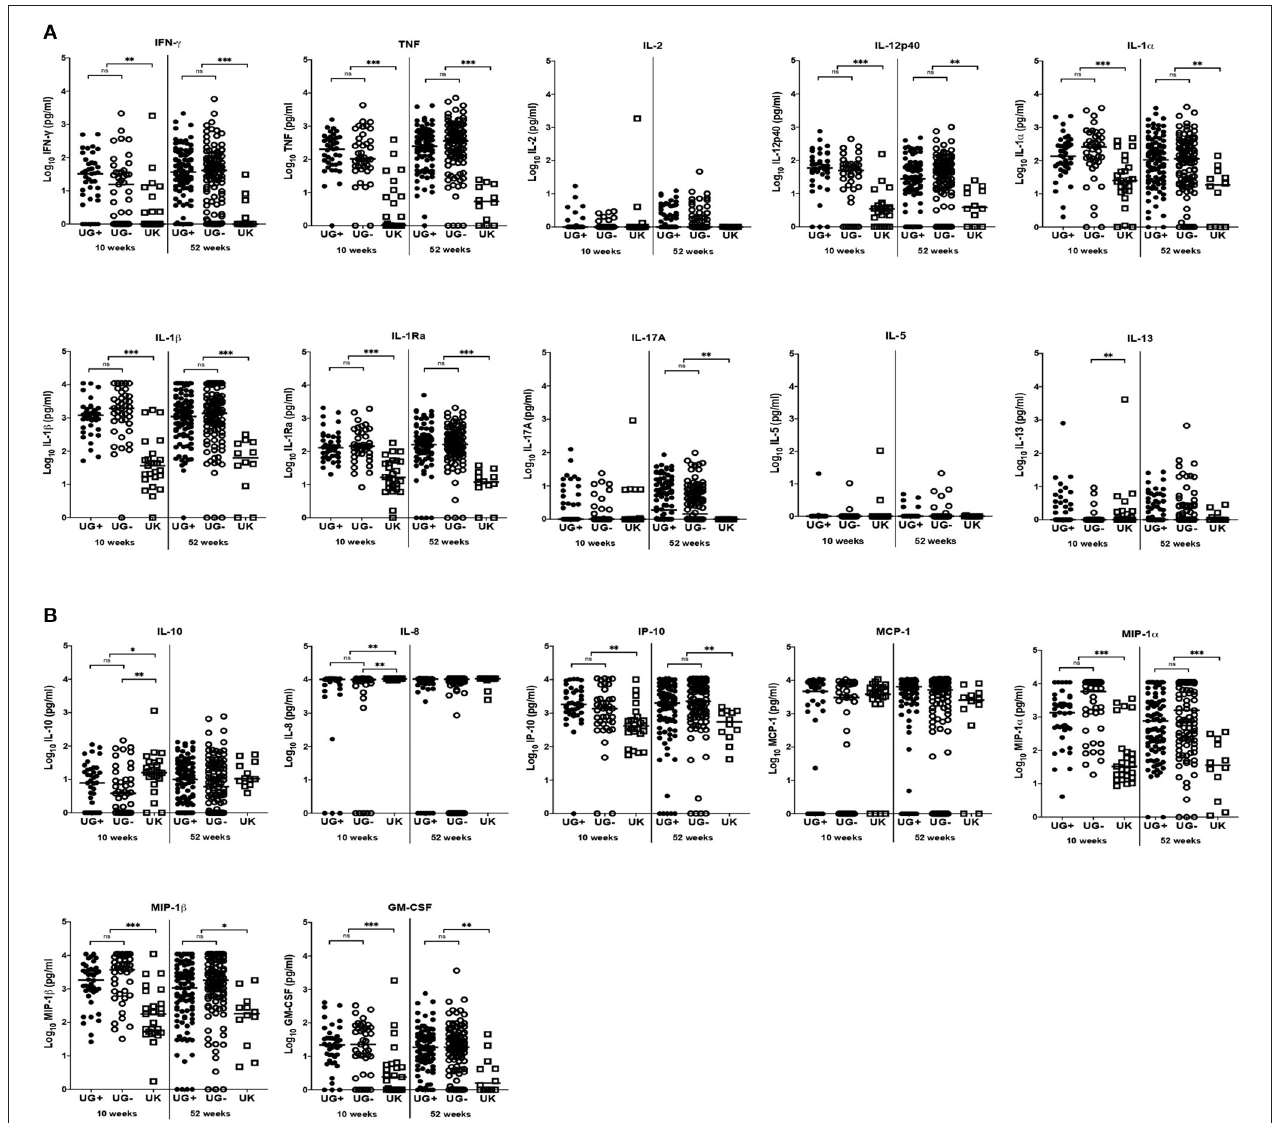
FIGURE 2 | Comparison of immune response to ESAT6/CFP10 in infants from Uganda and United Kingdom. (A) Median IFN- γ , TNF, IL-2, IL-12p40, IL-1 α , IL-1 β , IL-1Ra, IL-17A, IL-5, and IL-13 production following 6-day stimulation of whole blood with ESAT6/CFP10 in infant samples obtained at 10 and 52 weeks after BCG immunization. These are presented on the log scale in pg/ml. Closed and open circles represent Ugandan infants of mothers with (UG + ) and without (UG–) LTBI, respectively. Open squares represent infants in the UK. The asterisk (*) represents ** p < 0.001, *** p < 0.0001. ns, not statistically significant. (B) Median IL-10, IL-8, IP-10, MCP-1, MIP-1 α , MIP-1 β , and GM-CSF production following 6-day stimulation of whole blood with ESAT6/CFP10 in infant samples obtained at 10 and 52 weeks after BCG immunization. These are presented on the log scale in pg/ml. Closed and open circles represent Ugandan infants of mothers with (UG + ) and without (UG–) LTBI, respectively. Open squares represent infants in the UK. The asterisk (*) represents ** p < 0.001, *** p < 0.0001. ns, not statistically significant.